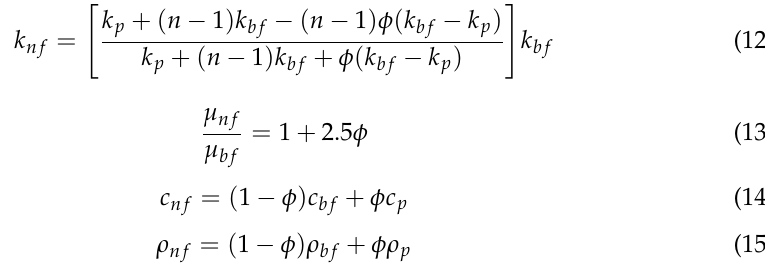
Table 1. Thermophysical properties of Nanoparticles and Pure Water at 303.15 K.